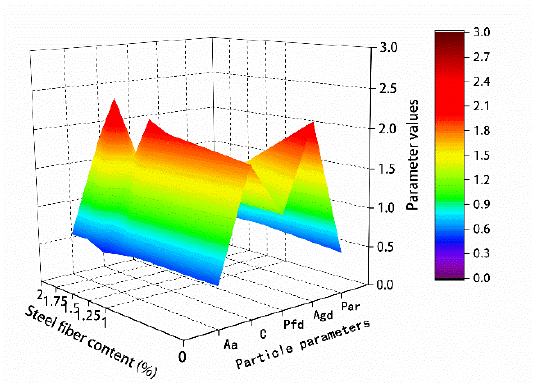
Figure 18. Particle size percentage content.